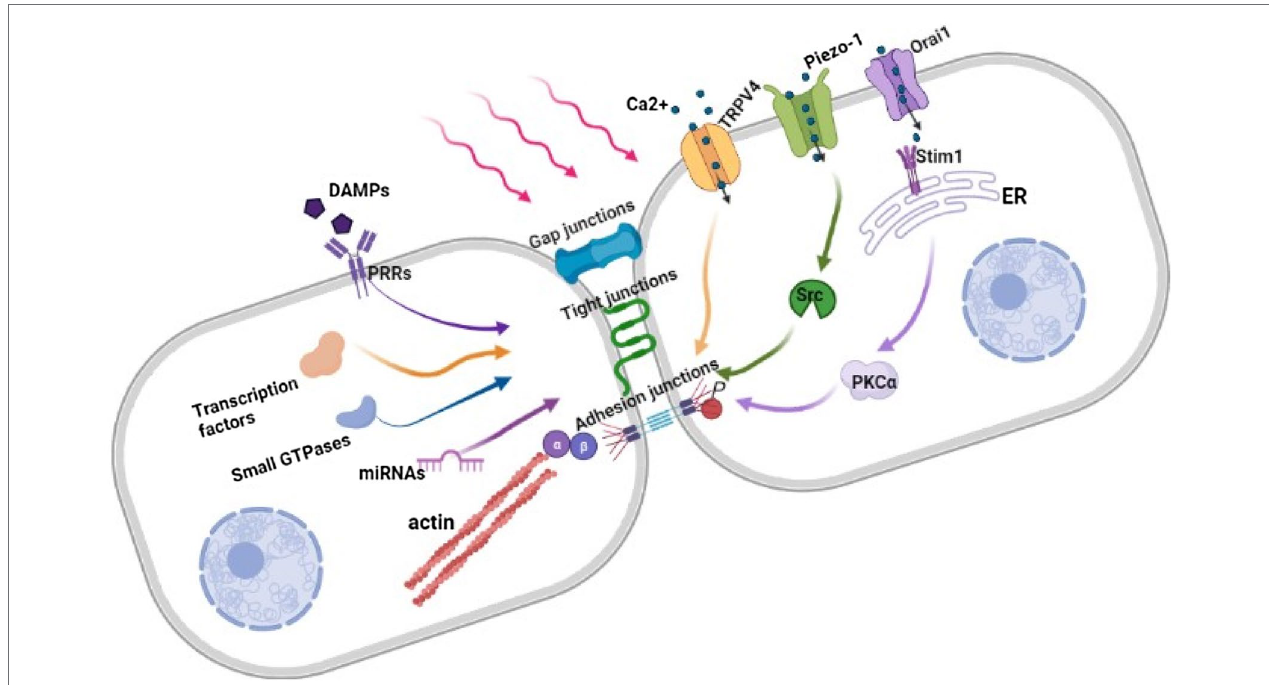
FIGURE 1 | Regulation of Endothelial barrier in response to mechanical force. Under mechanical stimuli, the combination of DAMPs and PRRs, the influx of Ca 2+ through opened mechanosensitive ion channels and changes in gene expression destruct intercellular structures further leads to cytoskeleton contracting and widening intercellular space. β , β -catenin; α , α -catenin; HMGB1, High-mobility group box 1; DAMPs, Damage-associated molecular patterns; PRRs, Pattern recognition receptors; TRPV4, Transient receptor potential vanilloid 4; Stim1, Stromal-interacting molecule 1; ER, Endoplasmic reticulum; PKC α , Protein kinase C alpha; Src, Proto-oncogene tyrosine-protein